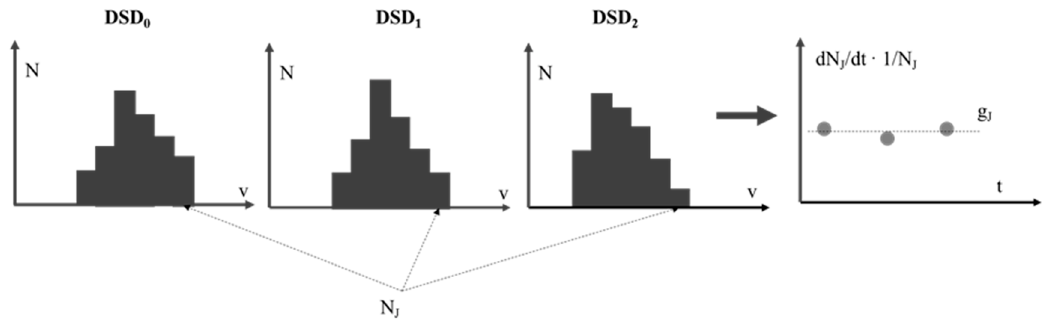
Figure 9. Illustrating how the decrease in the largest size-class, N J , can be used to back-calculate the fragmentation rate, g J .